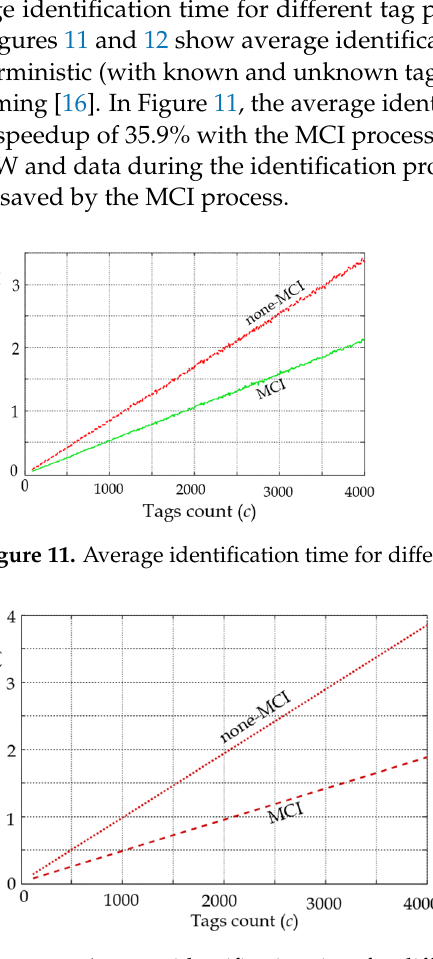
Figure 12. Average identification time for different unknown tag populations in the deterministic tree-based algorithm.